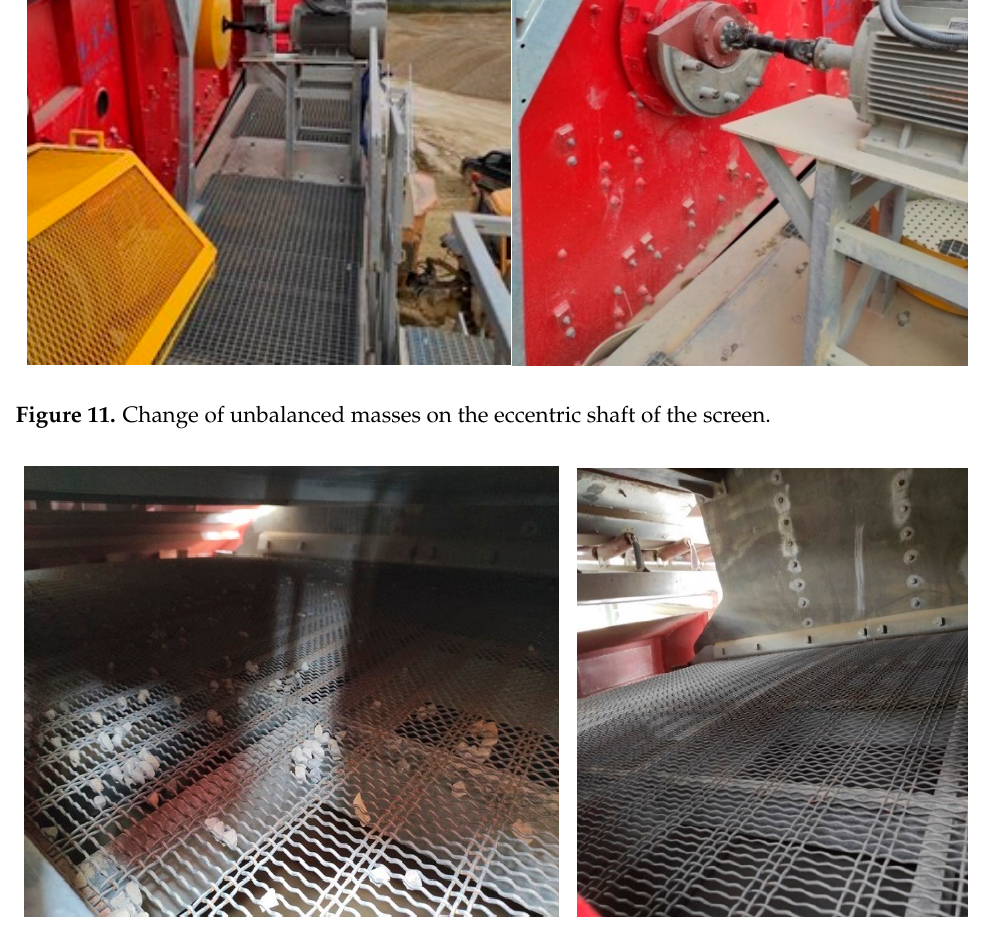
Figure 11. Change of unbalanced masses on the eccentric shaft of the screen. Table 9. Operating parameters of WSR screen.